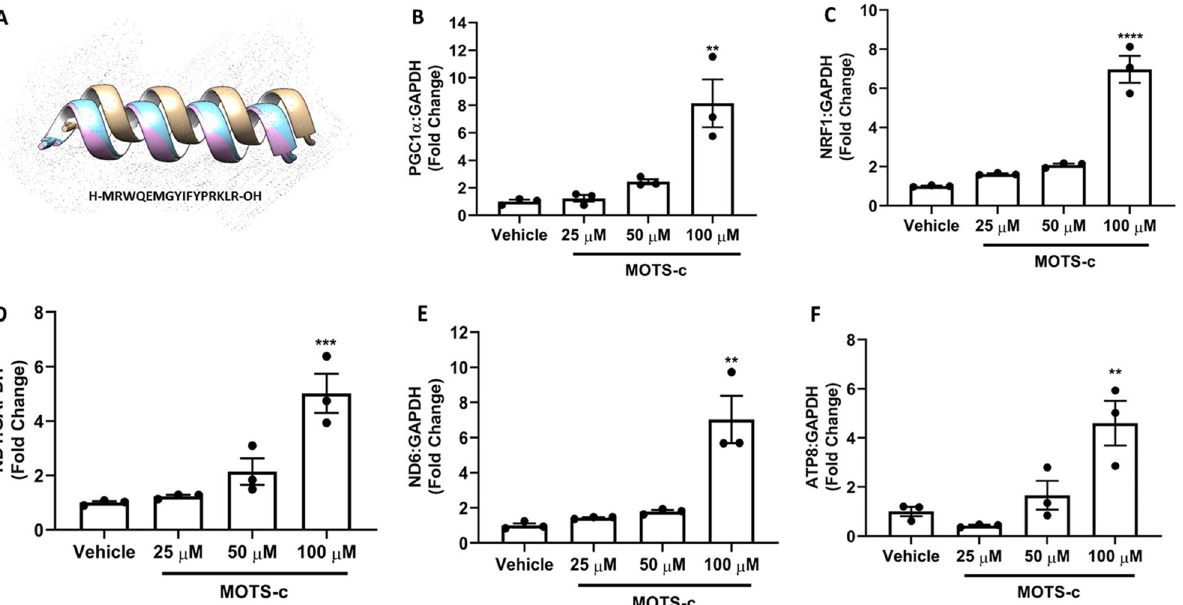
Figure 1. Treatment of U-2 OS cells with MOTS-c upregulated protein expression of selected biomarkers of mitochondrial biogenesis. ( A ) MOTS-c treatment increased mRNA expression of ( B ) PGC1α ( C ) NRF1 ( D ) ND1 ( E ) ND6 and ( F ) ATP8. U-2 OS cells grown in Dulbecco’s modified Eagle’s medium (DMEM) supplemented with 10% fetal bovine serum (FBS) plus 1% pen-strep were treated with vehicle (Nuclease-Free Water) or MOTS-c (25, 50 or 100 μM) for 48 h and qPCR was performed to quantify the mRNA expression levels of selected biomarkers. GAPDH was used as the internal control. Data are means ± SEM of